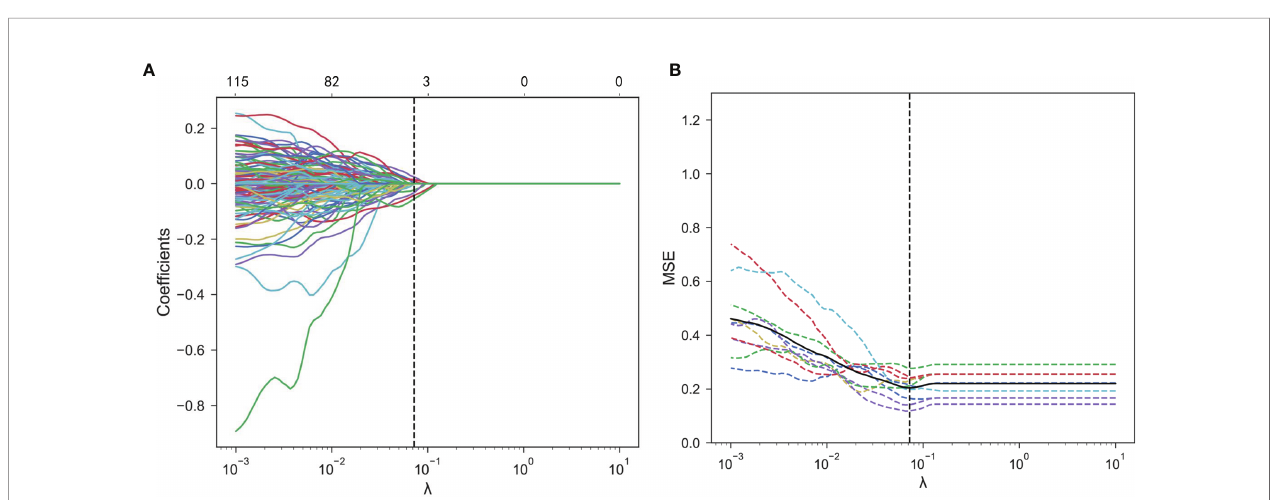
FIGURE 5 | Radiomics feature selection using the LASSO logistic regression. (A) Mean square error (MSE) path using 10-fold cross-validation. The dotted vertical line means that the optimal value of l was 0.072. (B) LASSO coef fi cient pro fi les of the 368 features. Six features with non-zero coef fi cients were selected at a l value of 0.072. LASSO, least absolute shrinkage and selection